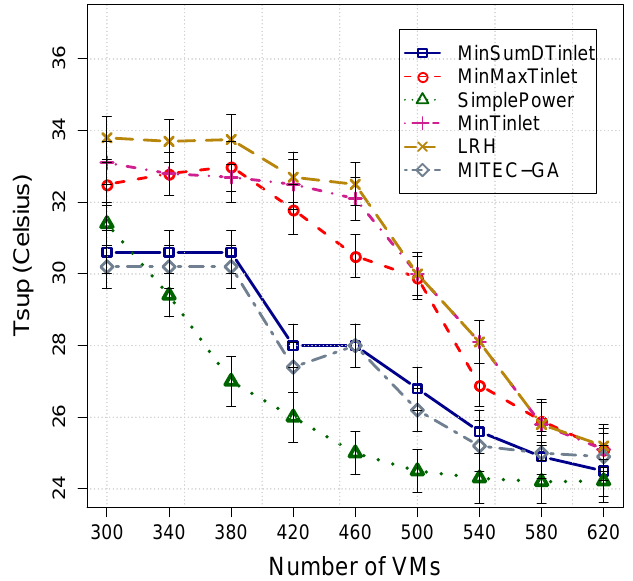
Figure 5. Supply temperature vs. VM